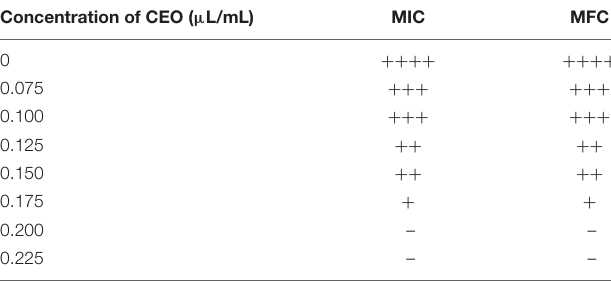
TABLE 2 | MIC and MFC of CEO against C.